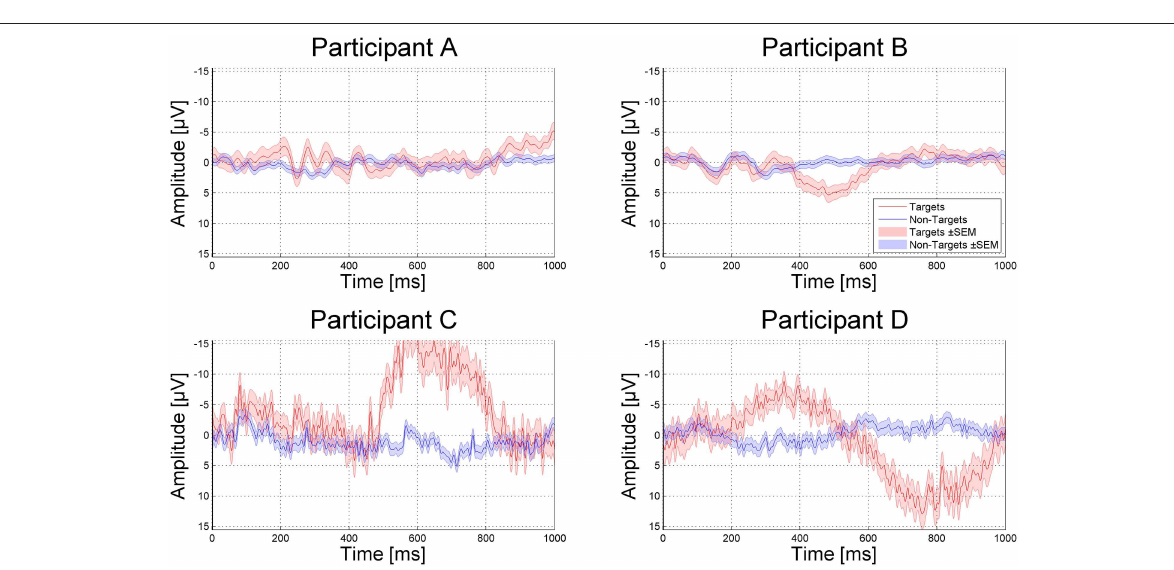
FIGURE 5 | P300 evoked by targets (red) compared to non-targets (blue) depicted from Cz. Red and blue shades indicate the standard error of the mean